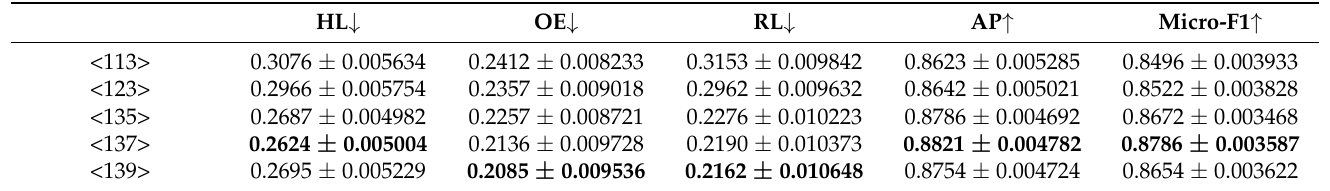
Table 4. Experimental results of weight setting of five groups (MEA ±